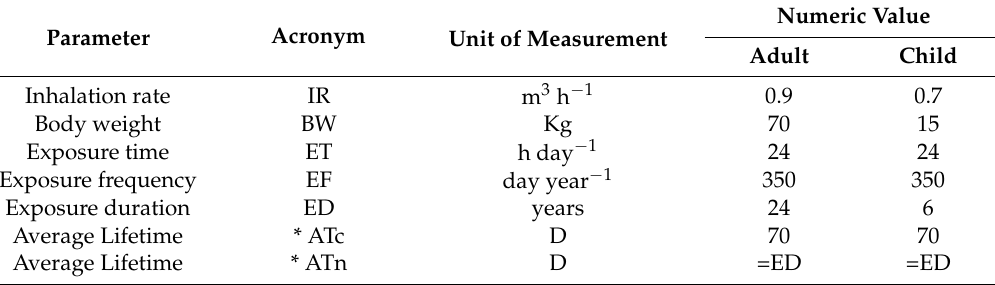
Table 2. List of parameters utilized for the calculation of the specific